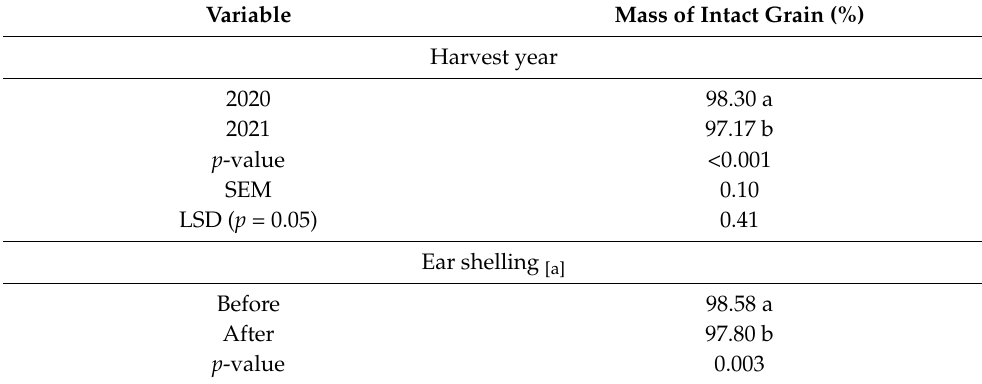
Table 5. Reported grain damage